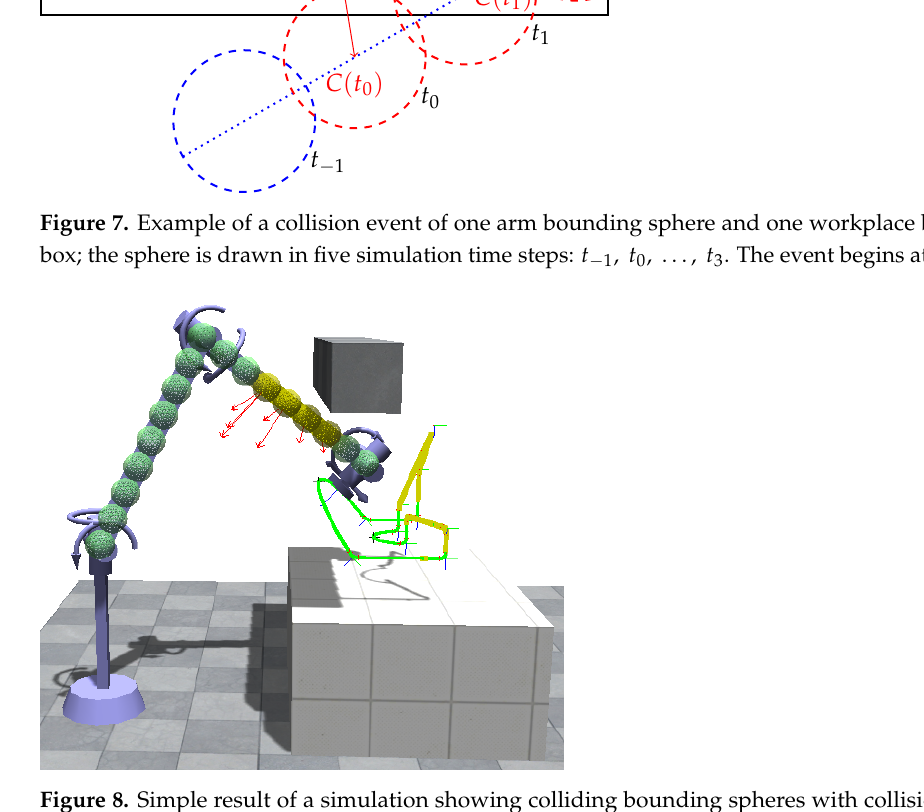
Figure 8. Simple result of a simulation showing colliding bounding spheres with collision events (red